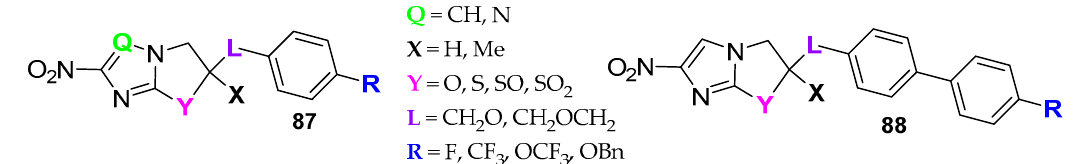
Figure 20. New leads ( 87 , 88 ) against TB and neglected tropical diseases.